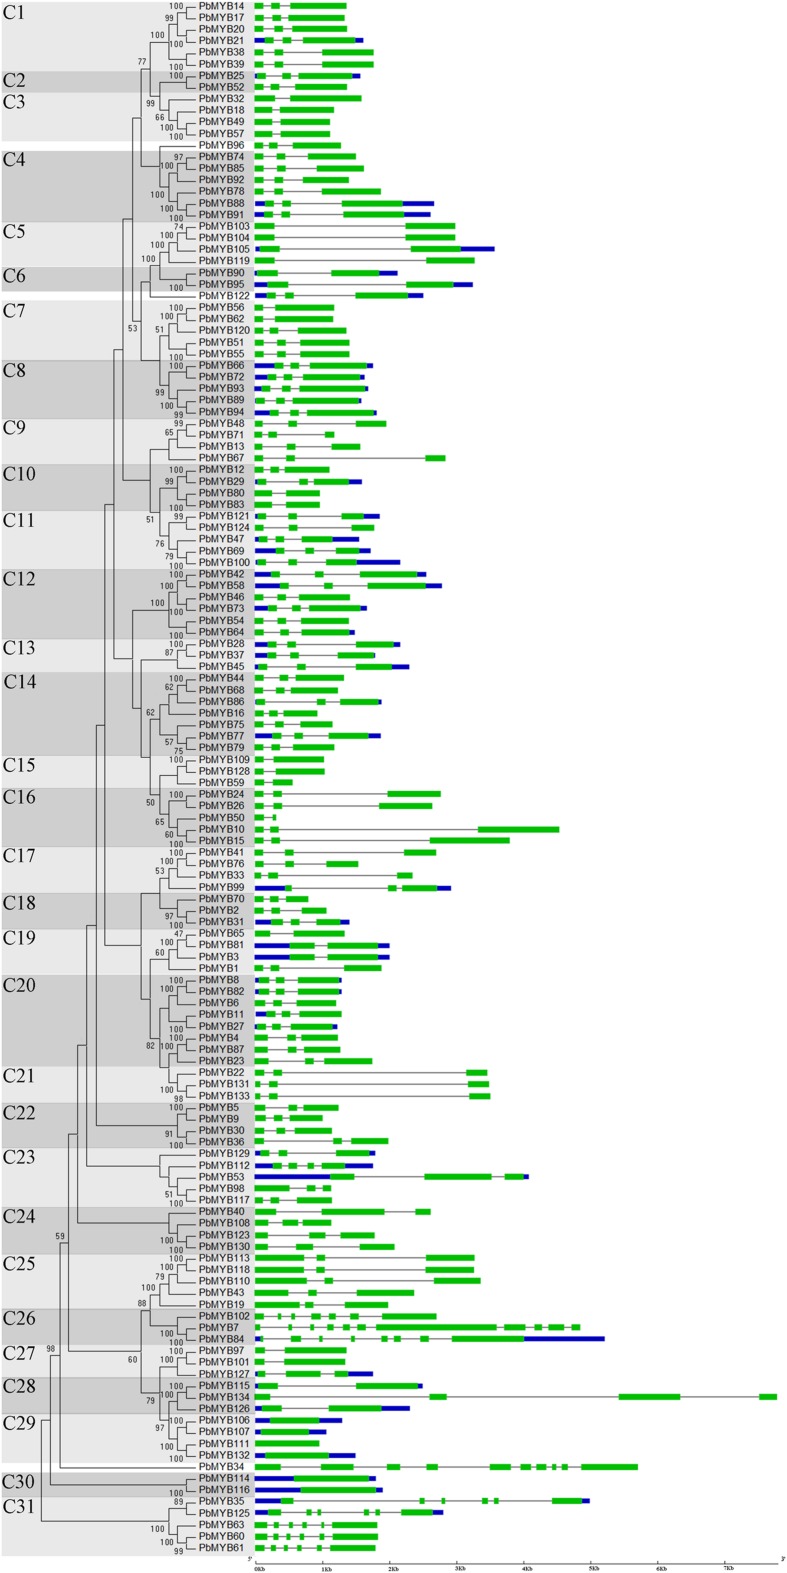
Phylogenetic analysis and exon–intron structures of pear MYB proteins. Complete alignments of all PbMYB proteins were used to construct a phylogenetic tree. The bootstrap values are indicated on the nodes of the branches. The green boxes, gray lines, and blue lines in the exon–intron structure diagram represent exons, introns, and UTRs, respectively. The scale on the bottom is provided as a reference.